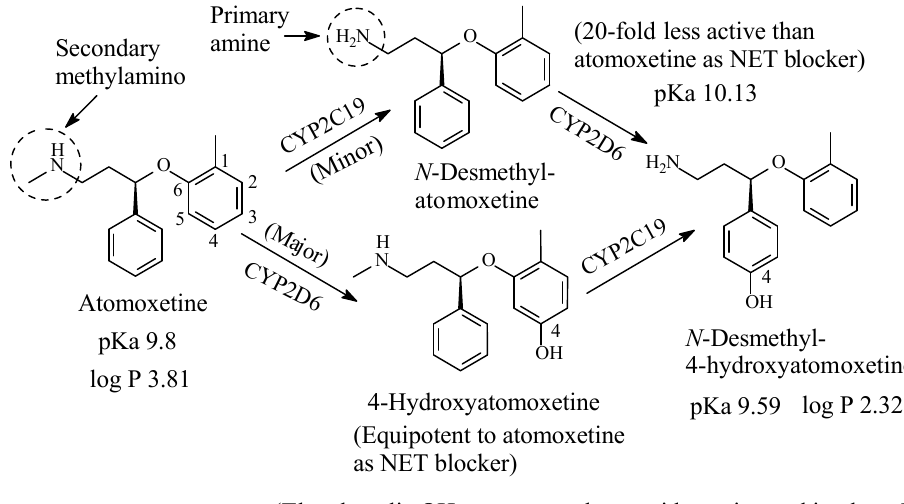
Figure 9. Metabolic pathways of atomoxetine.